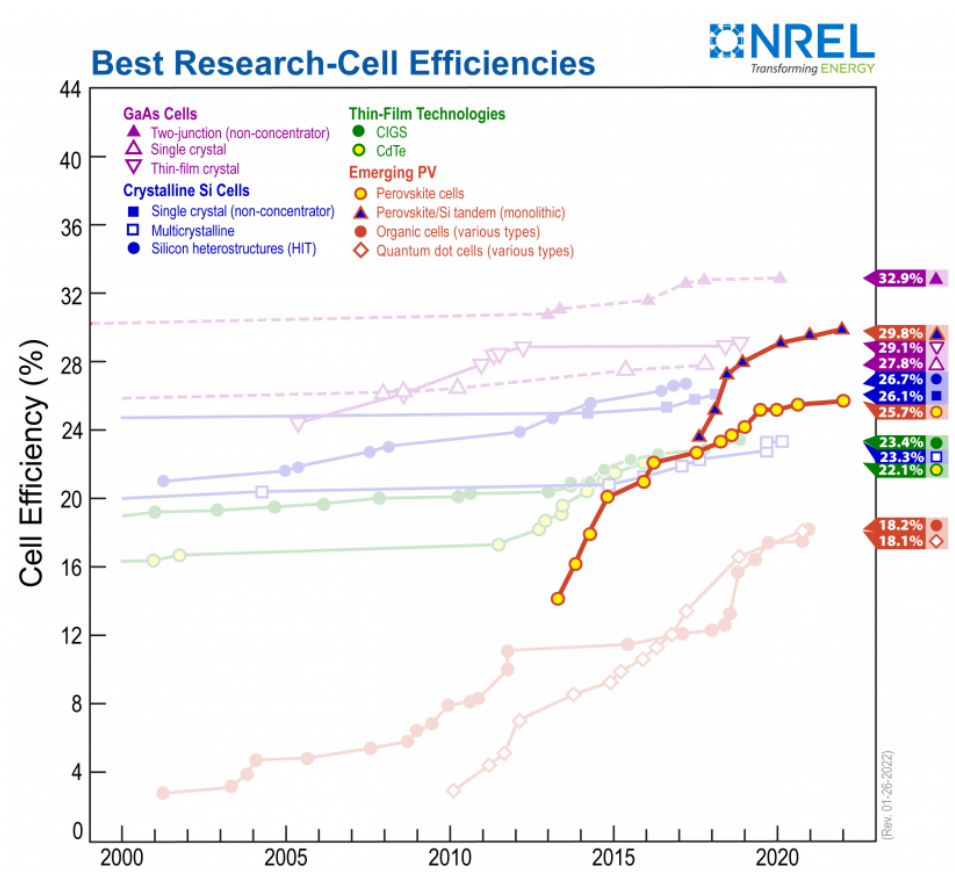
Figure 6. The efficiency records for perovskite solar cells and monolithic perovskite/Si tandem solar cells compared with other photovoltaic technologies [121].